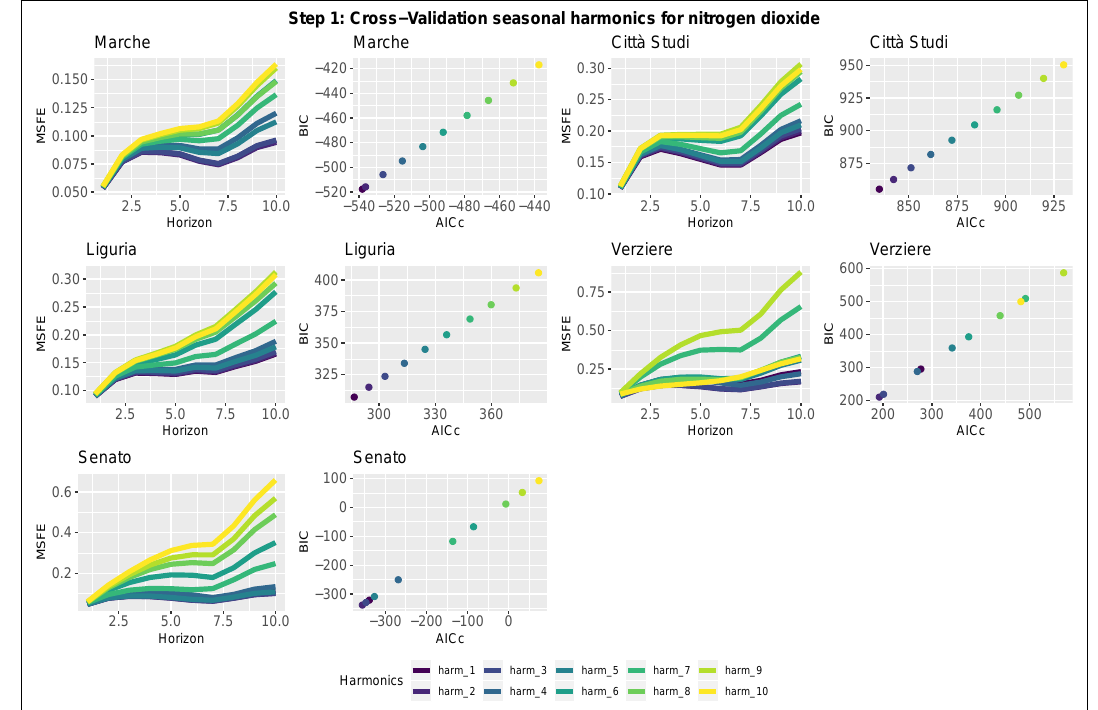
Figure 6. Model selection-Step 1-NO 2 . Seasonal component selection for the 5 nitrogen dioxide stations in Milan. Left panel: 10-steps-ahead MSFE in log-scale as function of the number of harmonics. Right panel: AICc and BIC pairs for each